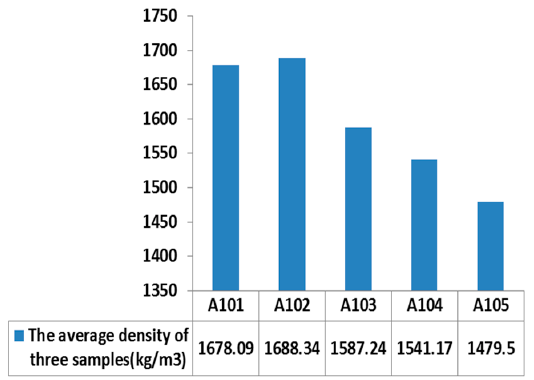
Figure 5. The test results of density (kg/m 3 ).